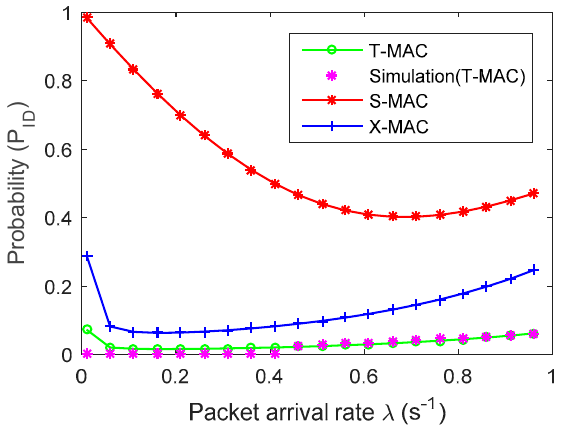
Figure 2. The idle probability P ID in a cycle versus the packet arrival rate (cid:104) for the T-MAC, S-MAC and X-MAC protocols.